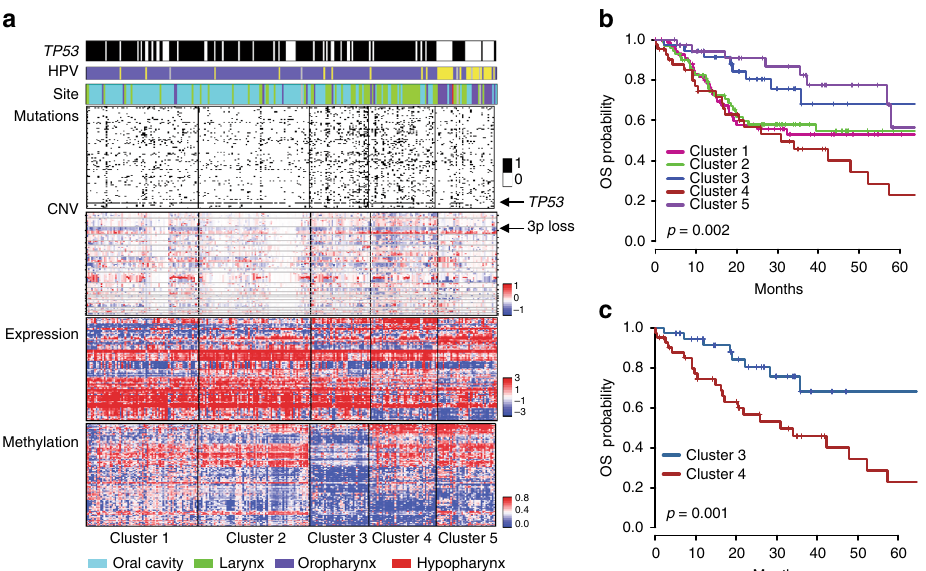
Fig. 1 Integrative clustering of 256 SCCHN tumors. a The top three rows indicate TP53 mutation (black), HPV status (purple = HPV – ; yellow = HPV + ; and gray = unknown), and tumor site. Mutation panels indicate individual mutations in the top 25% most commonly mutated genes; note the marked mutational burden in clusters 3 and 4. CNV indicates the heatmap of chromosomal gains (red) and losses (blue). For gene expression, the heatmap indicates overexpression (red) or underexpression (blue) of genes; speci fi c gene IDs are provided in Supplementary Data 1, and gene ontology (GO)- enriched categories are provided in Supplementary Data 2. For methylation, a heatmap plots β values of the probes as unmethylated (blue) or methylated (red). Genes corresponding to probes and enriched GO categories for methylation are listed in Supplementary Data 1 and 3, respectively. b Kaplan – Meier (KM) overall survival (OS) curves for all clusters identi fi ed in a . The p- value (log-rank test) indicates a strong evidence against the null hypothesis that the risk of death is similar across all SCCHN clusters. c . KM OS curves for clusters 3 and